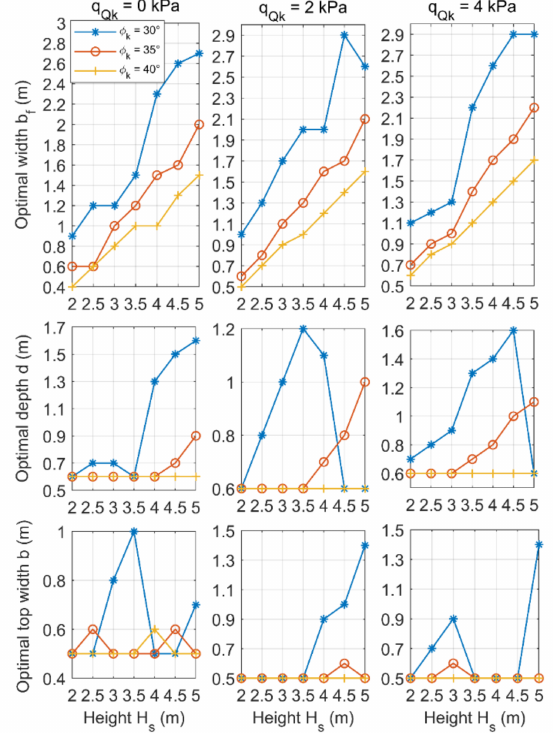
Figure 7. Optimal design for k = 2/3, β = 10 ◦ and γ = 18 kN/m 3